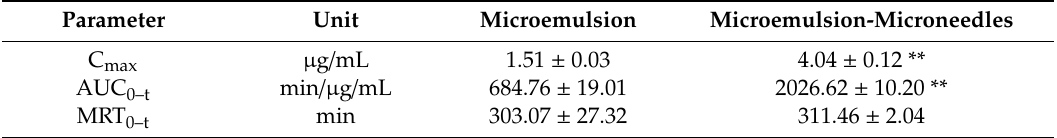
Table 1. Pharmacokinetic parameters of aconitine loaded into microemulsion sampled using microdialysis after application on rat abdominal skin in vivo ( n = 3).